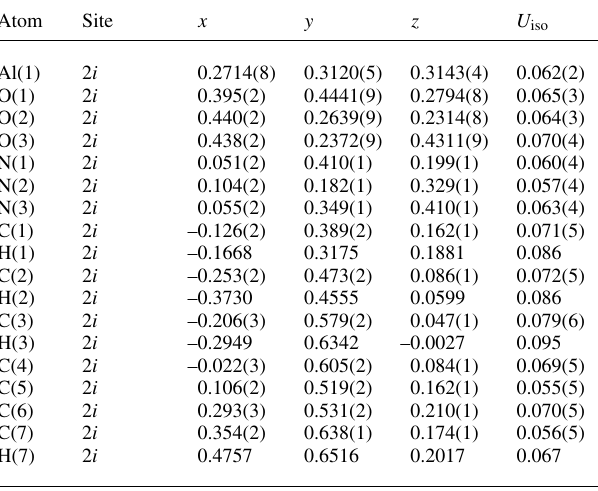
Table 2. Atomic coordinates and displacement parameters (in Å 2 )